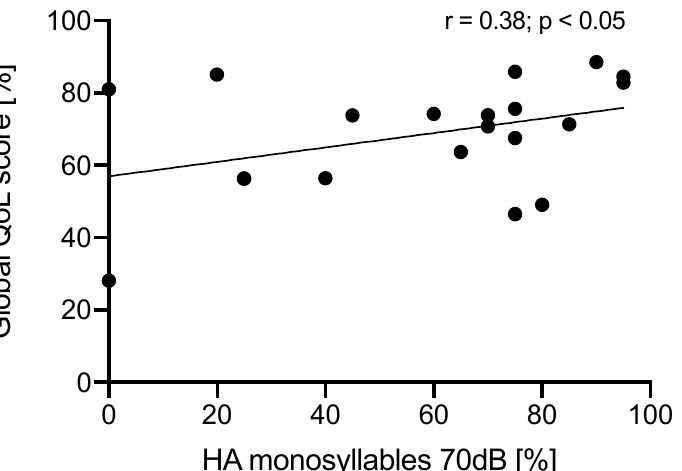
Figure 4. NCIQ global QoL scores preoperatively, and at 6 and 12 postoperative months. Asterisks indicate a significant difference in comparison with pre-OP: ** p < 0.005, *** p < 0.0005. Hashes indi- cate a significant difference in comparison with 6M: ### p < 0.0005 (for exact values see text). The global QoL score correlated with the SIM of the whole patient cohort (Pearson Figure 4 NCIQ global QoL scores. correlation analysis, r = 0.3821, p = 0.0482) (Figure 5). Figure 5 Correlation of SIM and NCIQ global QoL scores.